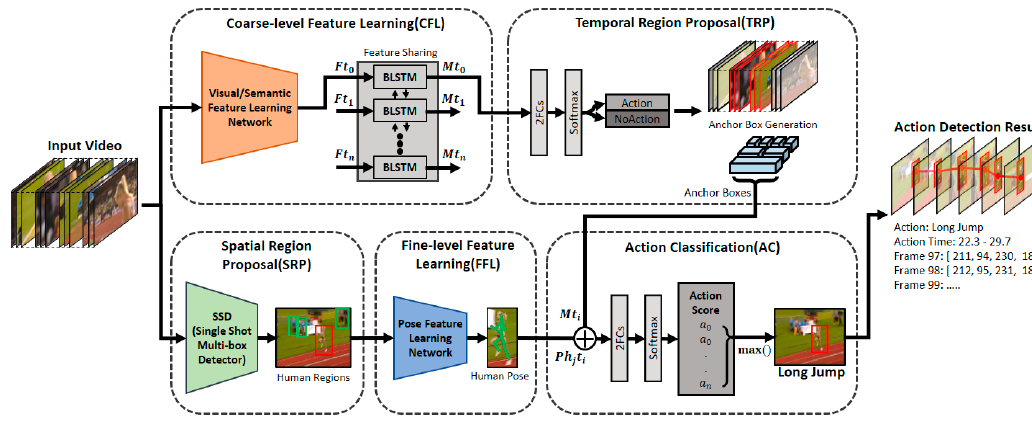
Figure 2. Spatio-temporal video-action-detection process.